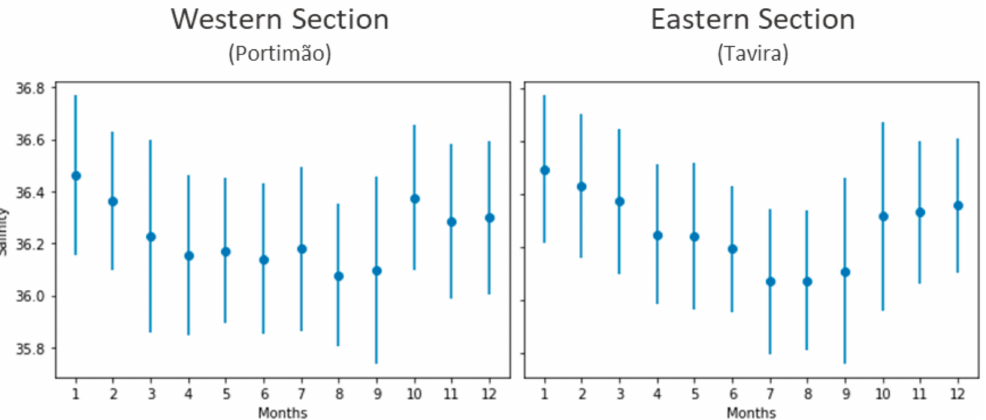
Figure 14. Monthly averages of the spatially averaged sea surface salinity obtained for the western and eastern sections of region E, considering the data from 2011 to